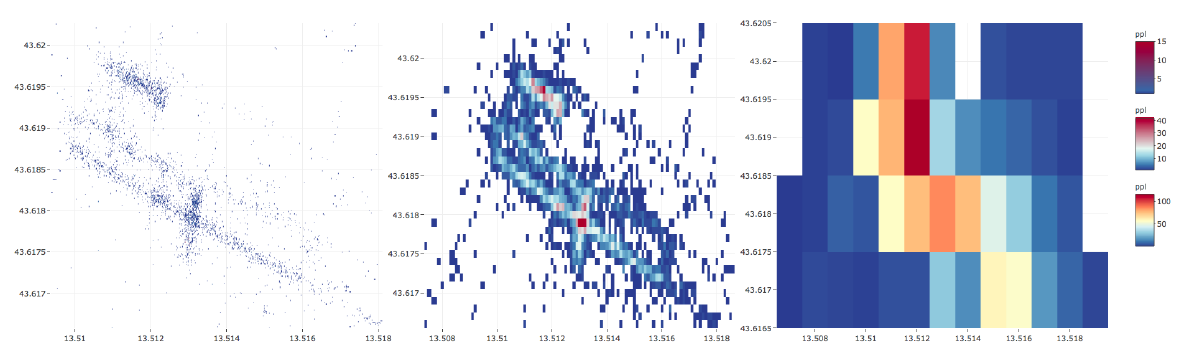
Figure 9. Spatial distribution. Ppl stands fpr number of people, while x and y axes represent geographical coordinates. age of people present at the event (y axis) w.r.t. the time of the day (x axis). This information is very important to infer the peak